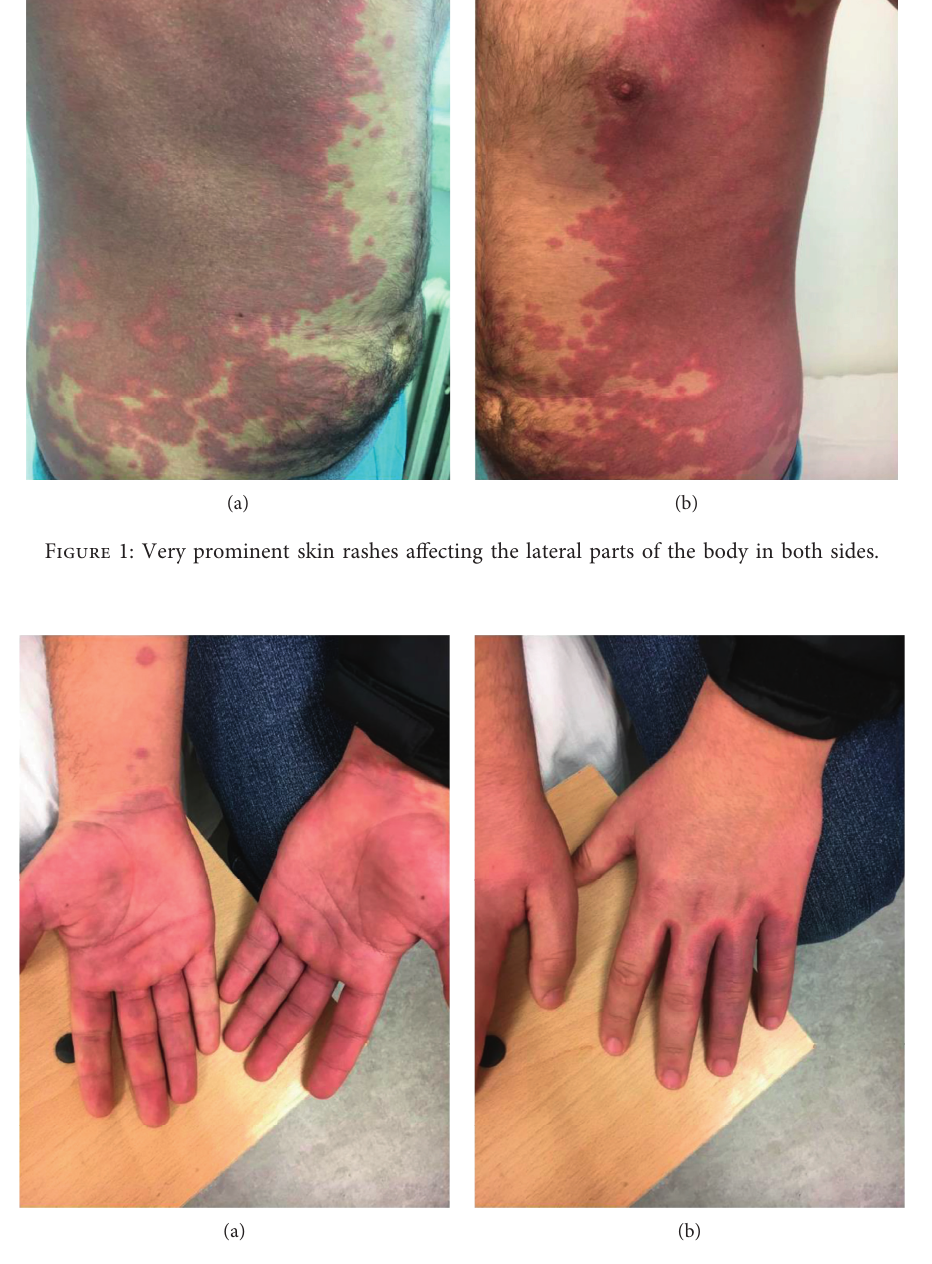
Figure 2: Skin rashes in the distal parts of the upper extremities and palmar